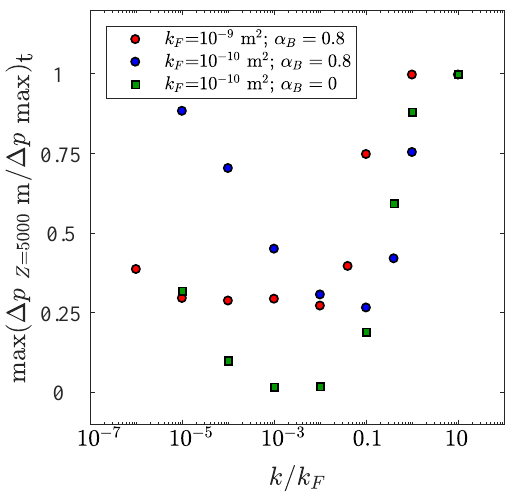
Figure 9. Effect of the host rock matrix permeability and poroelastic coupling on the pore pressure diffusion. We study the relation between both the rock matrix permeability and the Biot coefficient on the pore pressure build-up at 5 km depth. In order to quantify the effect of the poroelastic coupling, we adopt two values of the fault permeability (10 − 9 and 10 − 10 m 2 ), and two values of the Biot coefficient ( α B = 0 and 0.8). In both cases, we compute the ratio of the maximum pore pressure increment at 5 km depth to the maximum pore pressure increment on the seabed (which corresponds to the high tide). For each permeability ratio, the poroelastic coupling accounts for the difference between the blue dots and green squares. The parameters of these simulations are listed in Table 2. The Young modulus of the host rock and the fault are both 40 GPa.